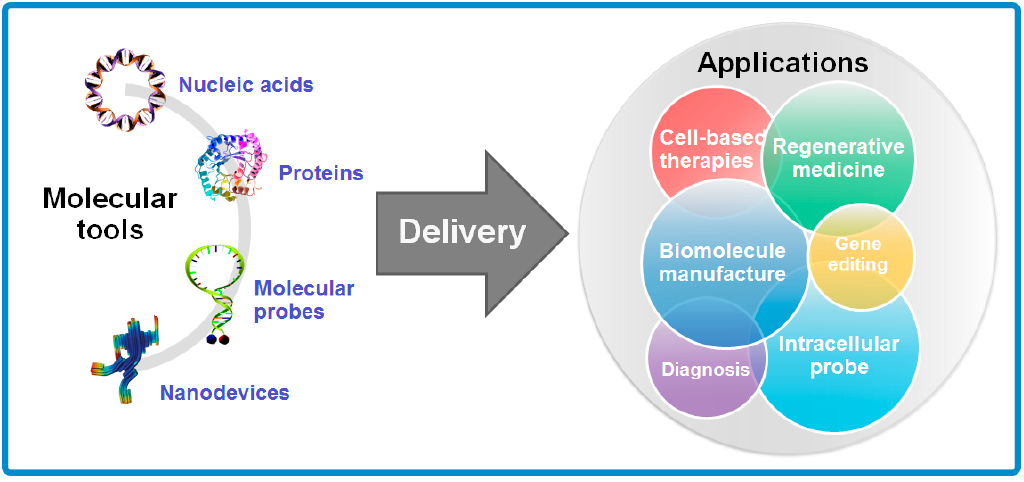
Figure 1. Various applications in different fields benefit from the development of molecular tools for intracellular delivery.